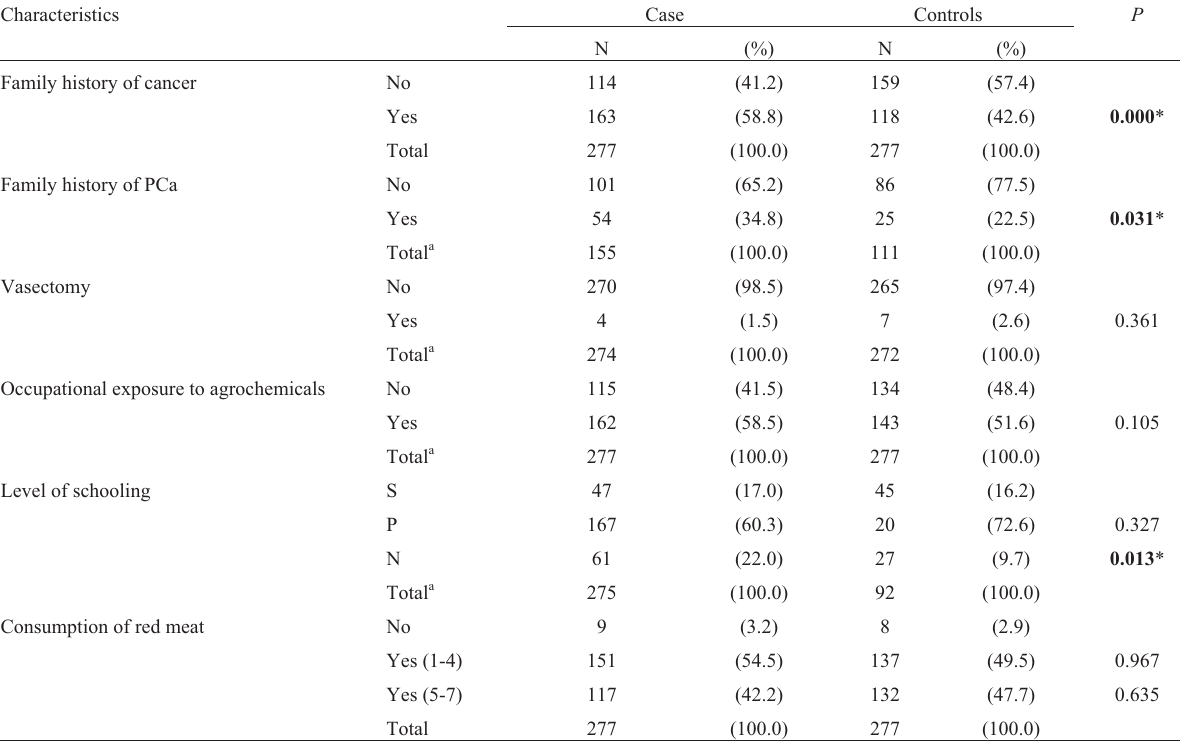
Table 1 - Demographic and clinical characteristics of prostate cancer patients and cancer-free controls.